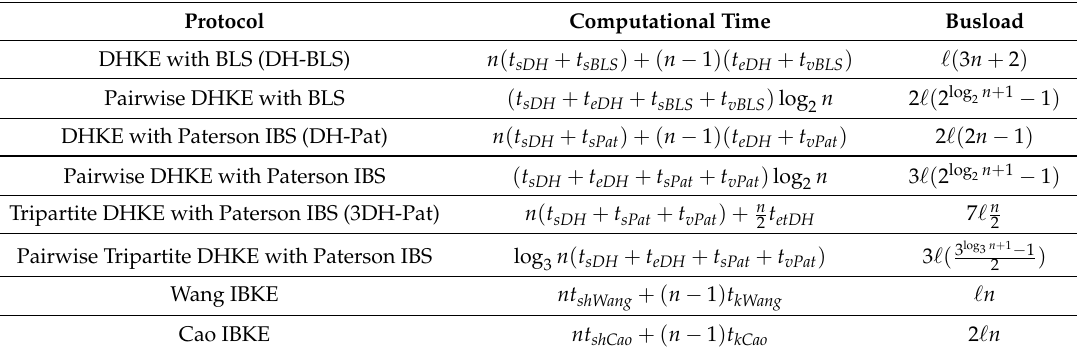
Table 4. Computational overhead and busload (synthetic